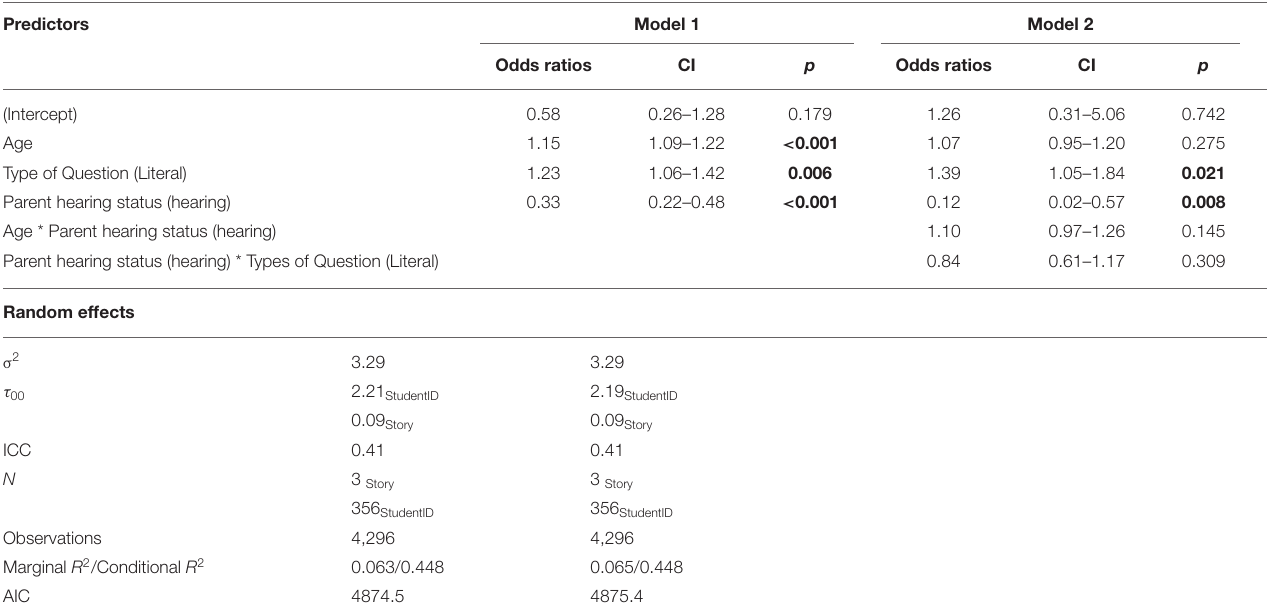
TABLE 2 | Mixed effects logistic regression of factors predicting accuracy on the